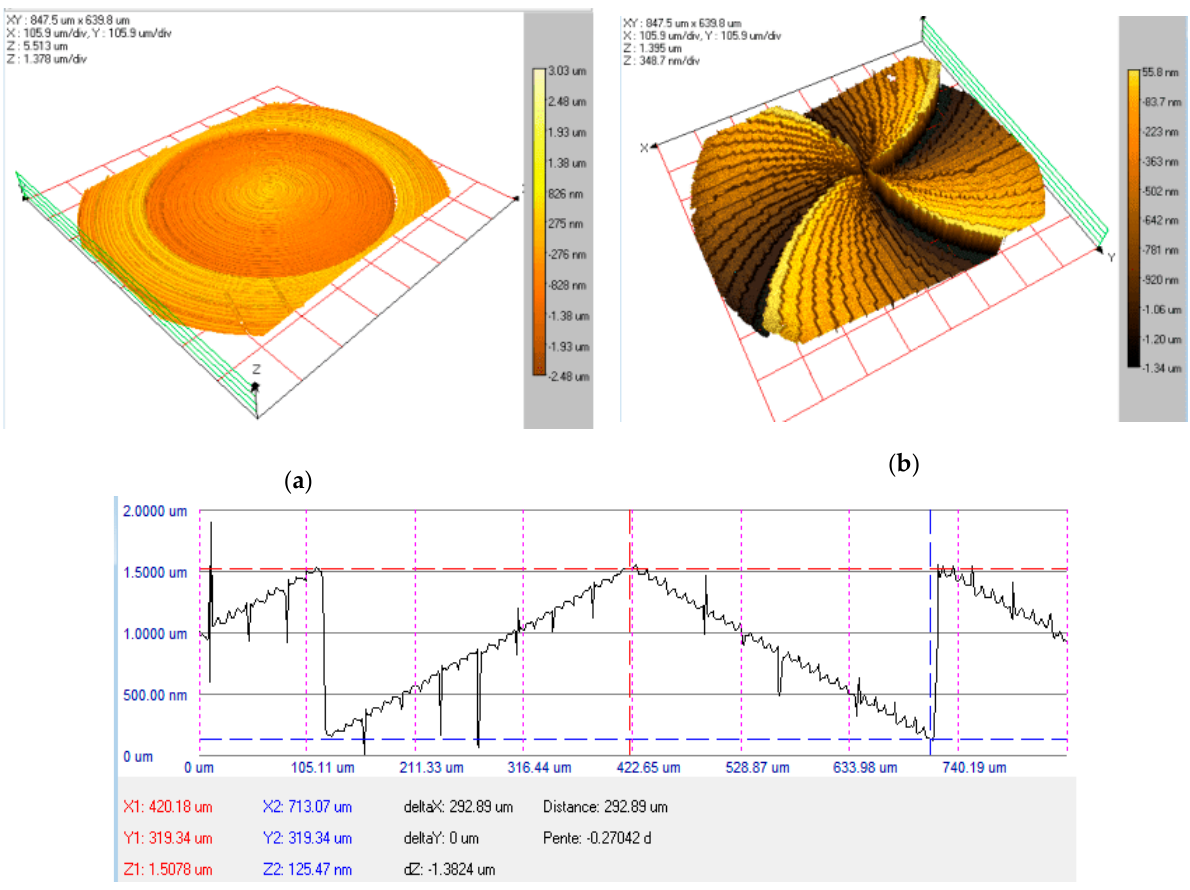
Figure 10. White light interferometry tridimensional maps for ( a ) zero-order axicon with 32 levels in fused silica, ( b ) spiral axicon with 32 levels in fused silica, ( c ) cross-section profile for zero-order axicon with 32 levels from Figure 10a.